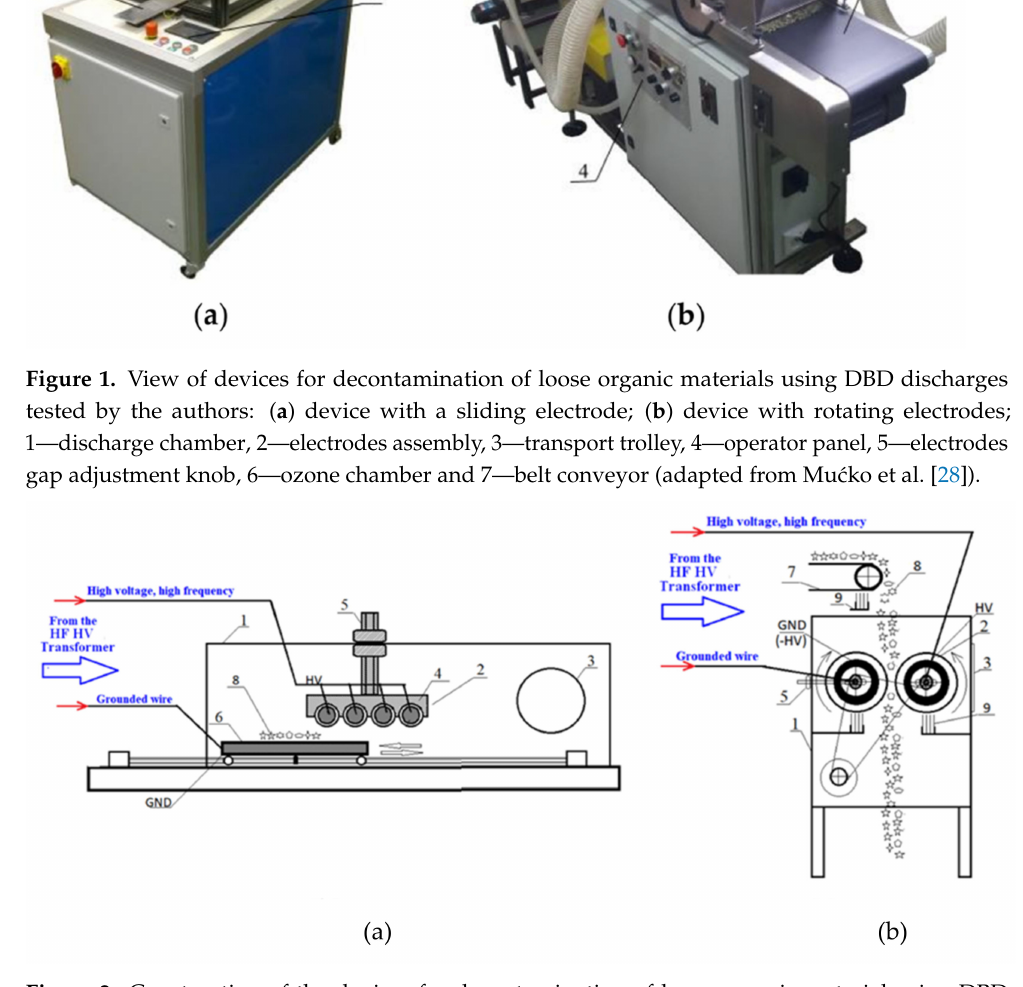
Figure 2. Construction of the devices for decontamination of loose organic material using DBD discharges: ( a ) discharge chamber with a sliding electrode; ( b ) discharge chamber with